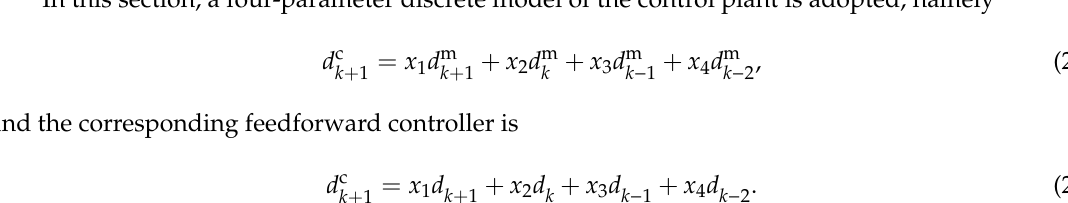
Figure 12. Evolutions of the estimated system model parameters.